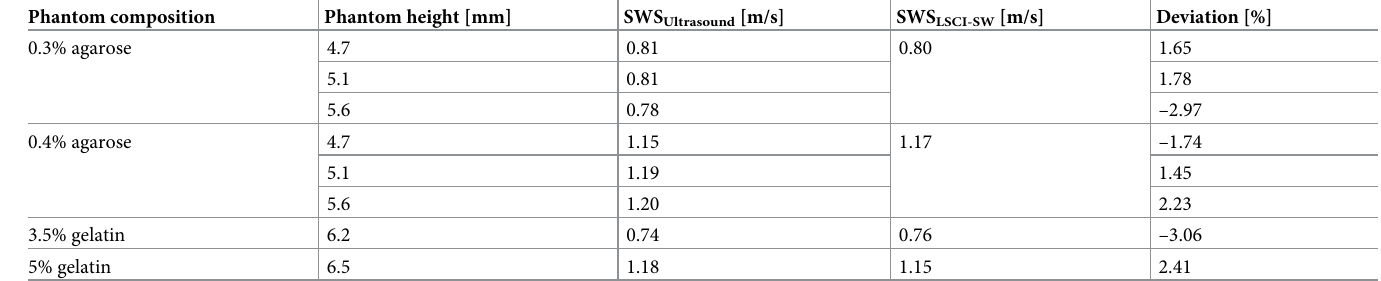
Table 1. Summary of the shear wave speeds (SWSs) estimated for different homogeneous phantoms by the single-element transducer ultrasound shear wave system and the laser-speckle contrast shear wave imaging (LSCI-SW) system. Phantom composition